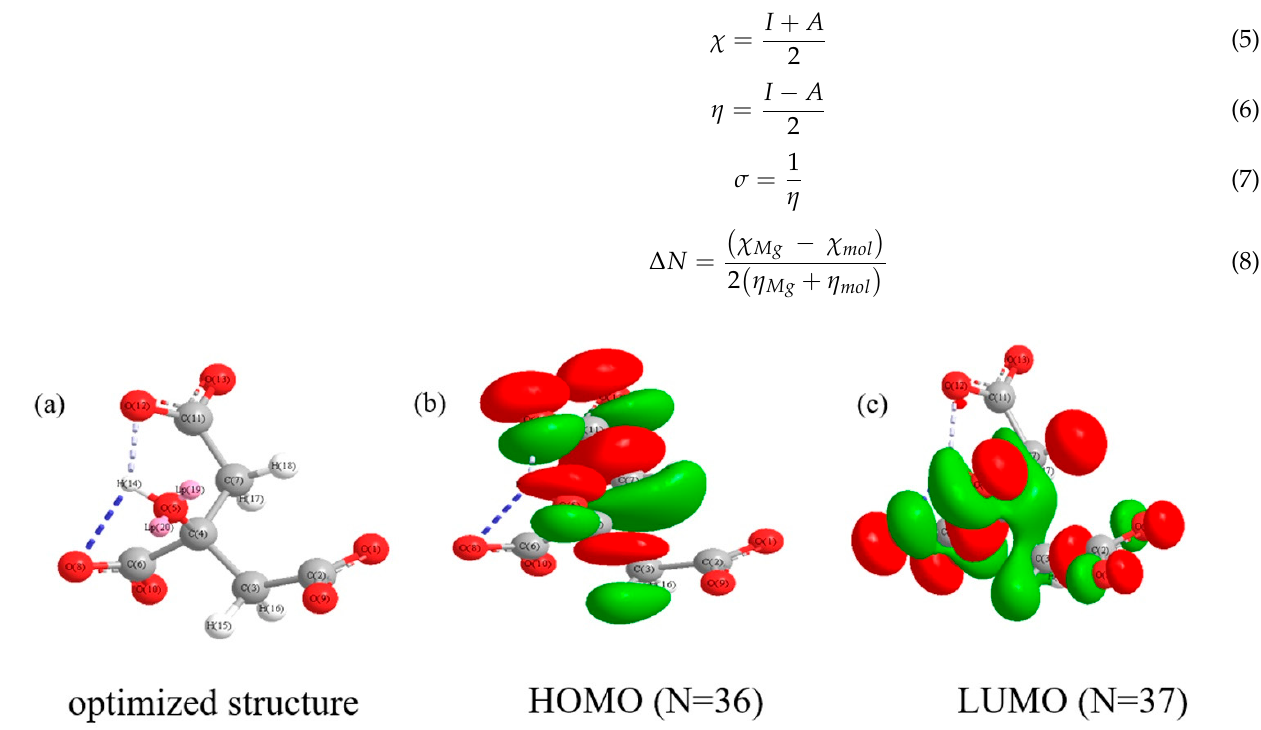
Figure 5. SEM images of the S0, S5, and S10 samples after electrochemical measurements. ( a ) S0 sample, ( b ) S5 sample, and ( c ) S10 sample.